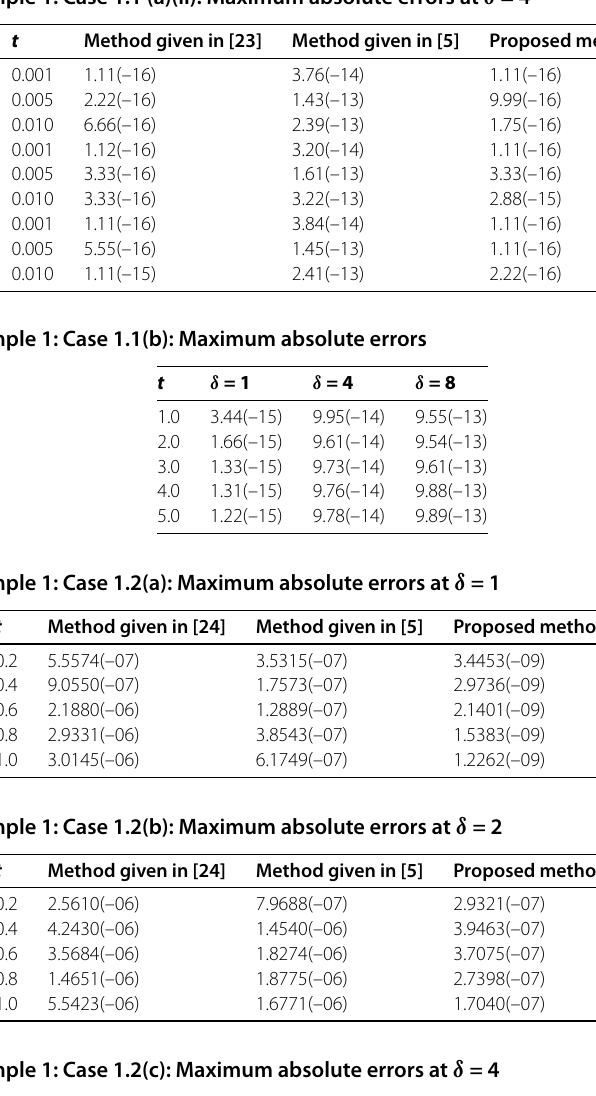
Table 2 Example 1: Case 1.1 (a)(ii): Maximum absolute errors at δ = 4